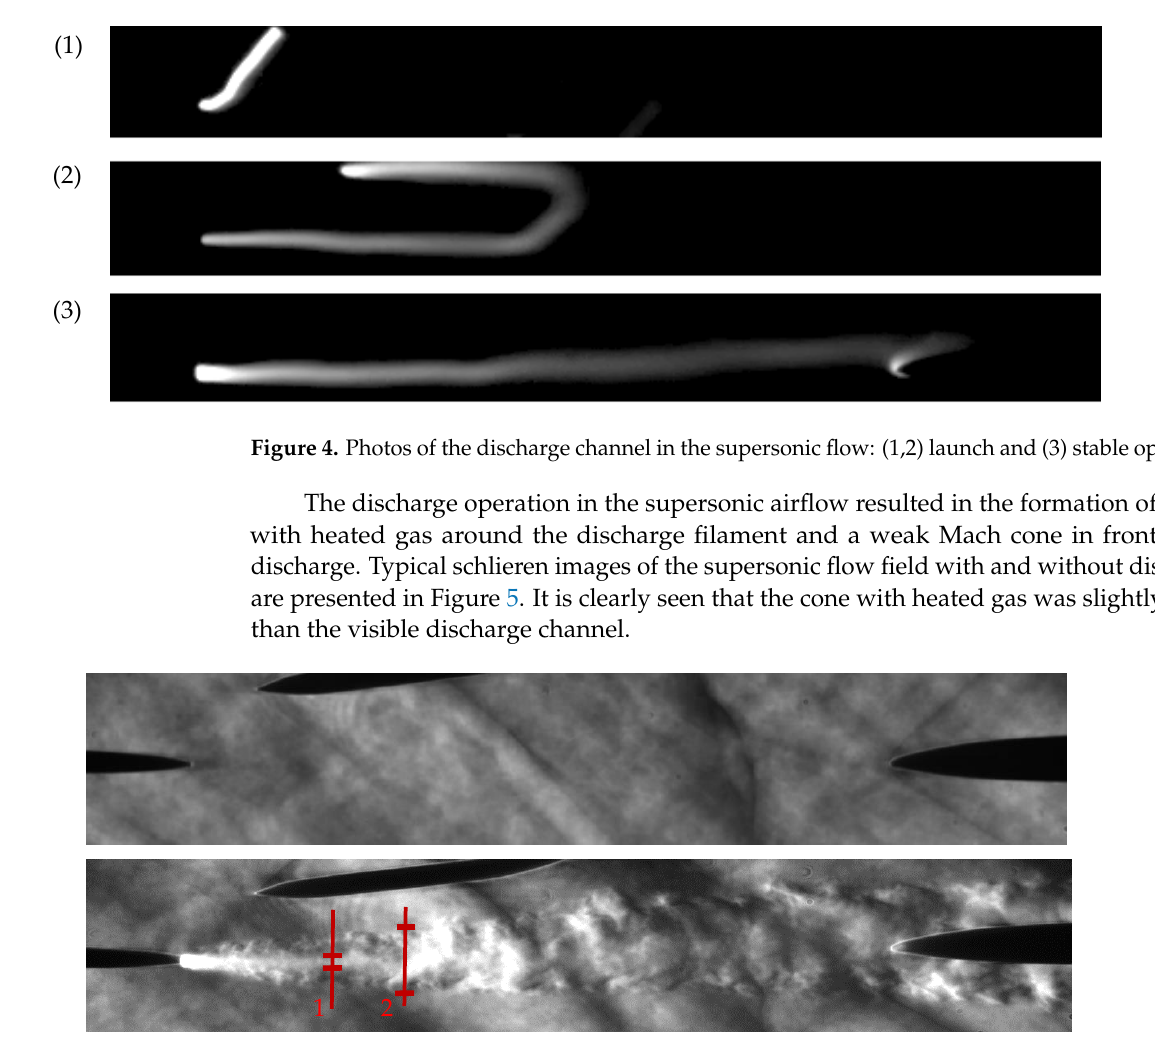
Figure 4. Photos of the discharge channel in the supersonic flow: (1 – 2) launch and (3) stable opera- tion.